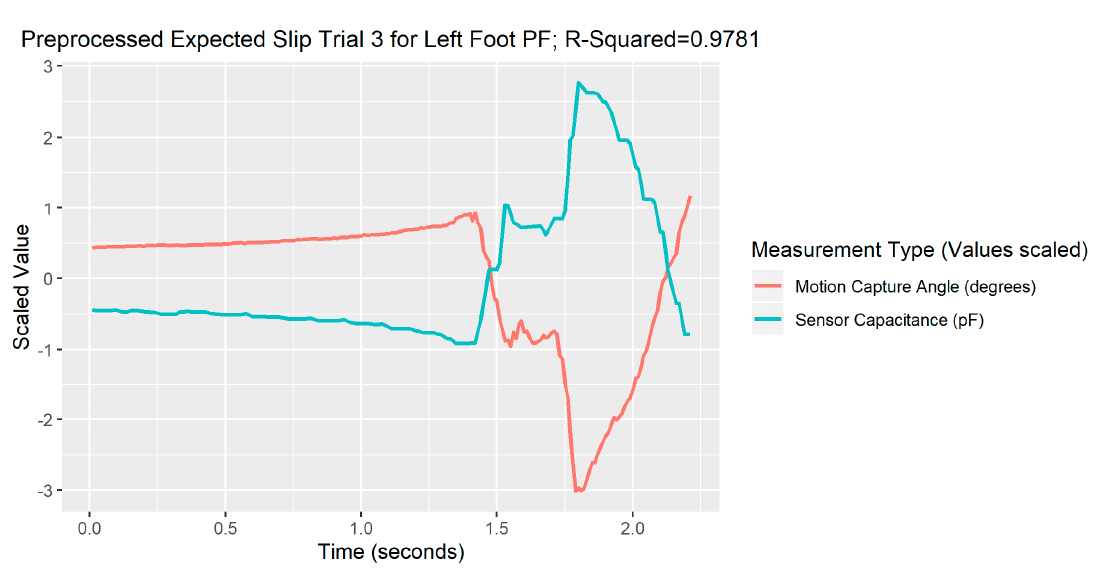
Figure 5. An example of a good processing trial that produced good/great result.